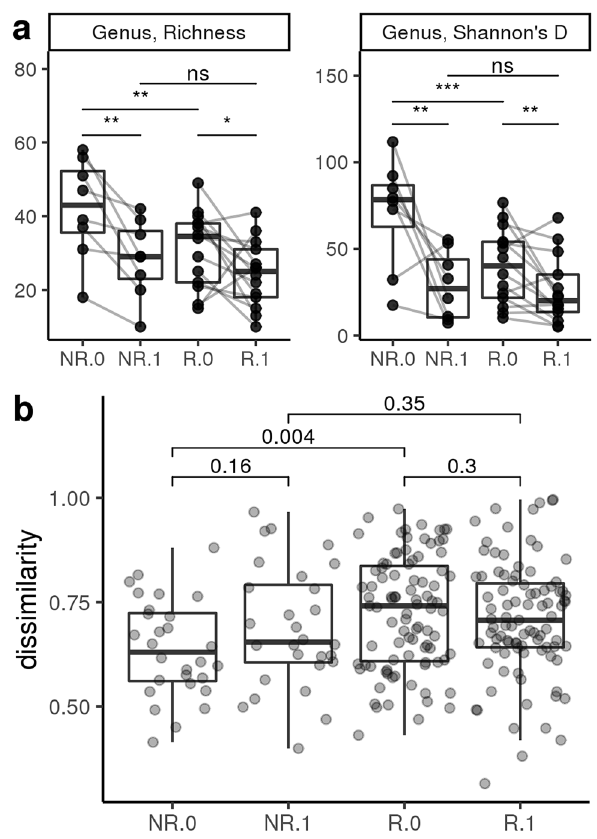
Figure 3. Diversity measures at the genus level of chronic enteropathy (CE) cats at time of diagnosis and post dietary intervention. NR = non-responder, R = responder, 0 = time of diagnosis, 1 = post dietary intervention ( a ) Genus richness (left panel) and diversity measured by Shannon’s Diversity Index (right panel) are lower in responders than non-responders at time of diagnosis. Dietary intervention resulted in decreased richness and diversity in both groups such that post-treatment diversity measures are not significantly different between responders and non-responders. Adjusted p-value < 0.0001 represented with ***. Adjusted p-value < 0.001 represented with **. Adjusted p-value < 0.01 represented with *. Adjusted p-value > 0.05 represented with ns. ( b ) Sample dissimilarity shows that responders have greater within-group dissimilarity than non-responders at the time of diagnosis. Following dietary intervention, non-responders and responders have equivalent within-group